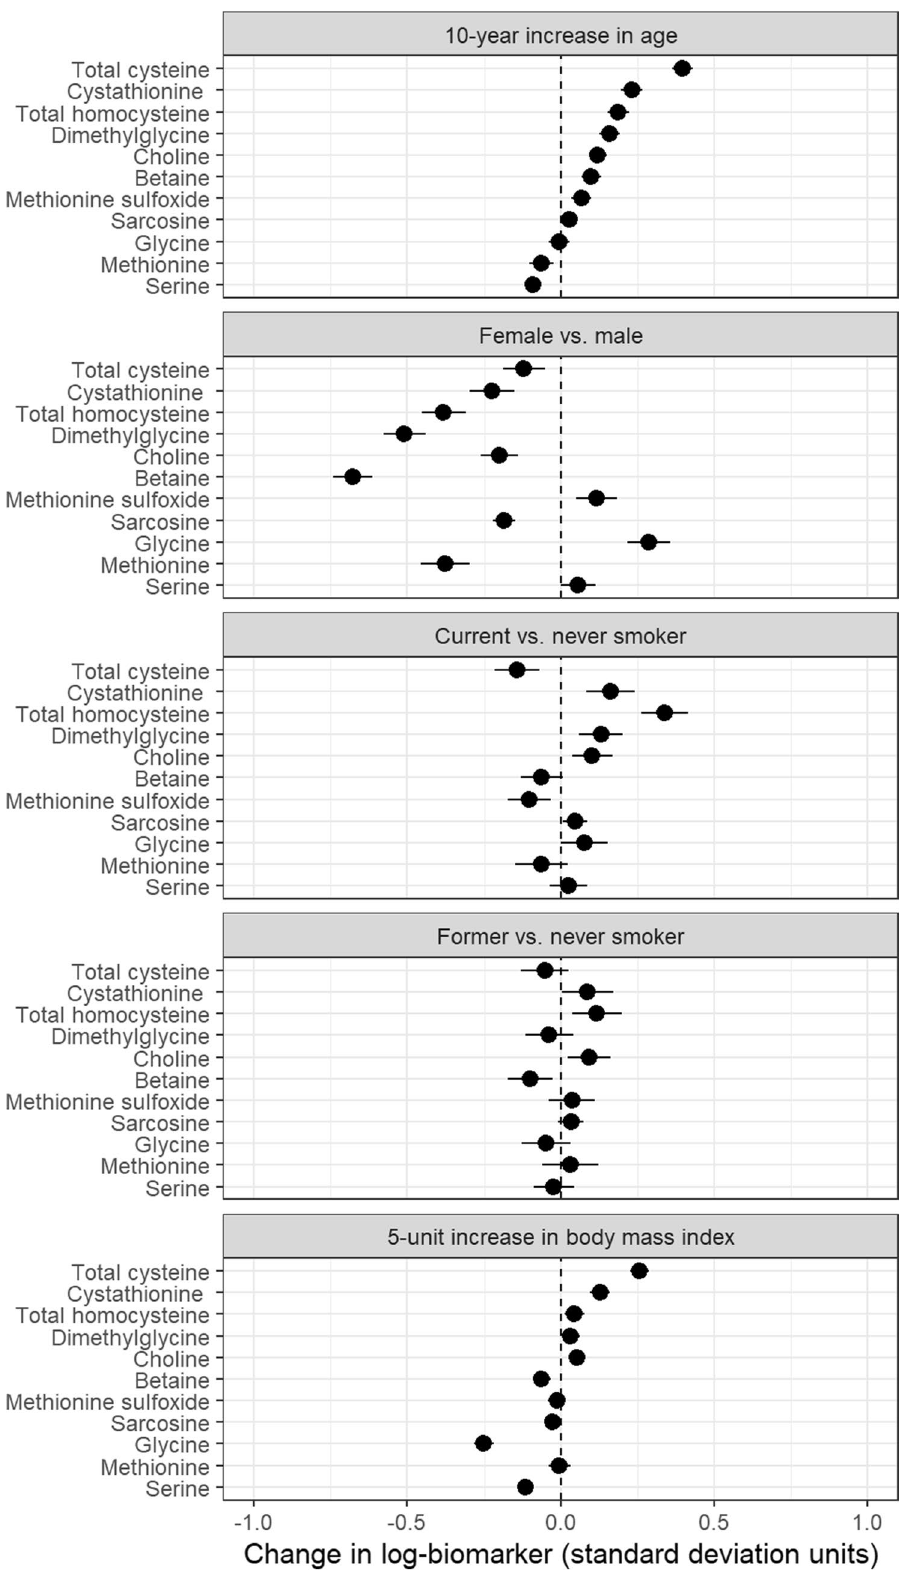
Figure 1. Differences in biomarkers of one-carbon metabolism by age, sex, smoking status, and BMI, in units of log-biomarker standard deviations, among 5167 control subjects in the Lung Cancer Cohort Consortium. Biomarkers are listed in order of the age